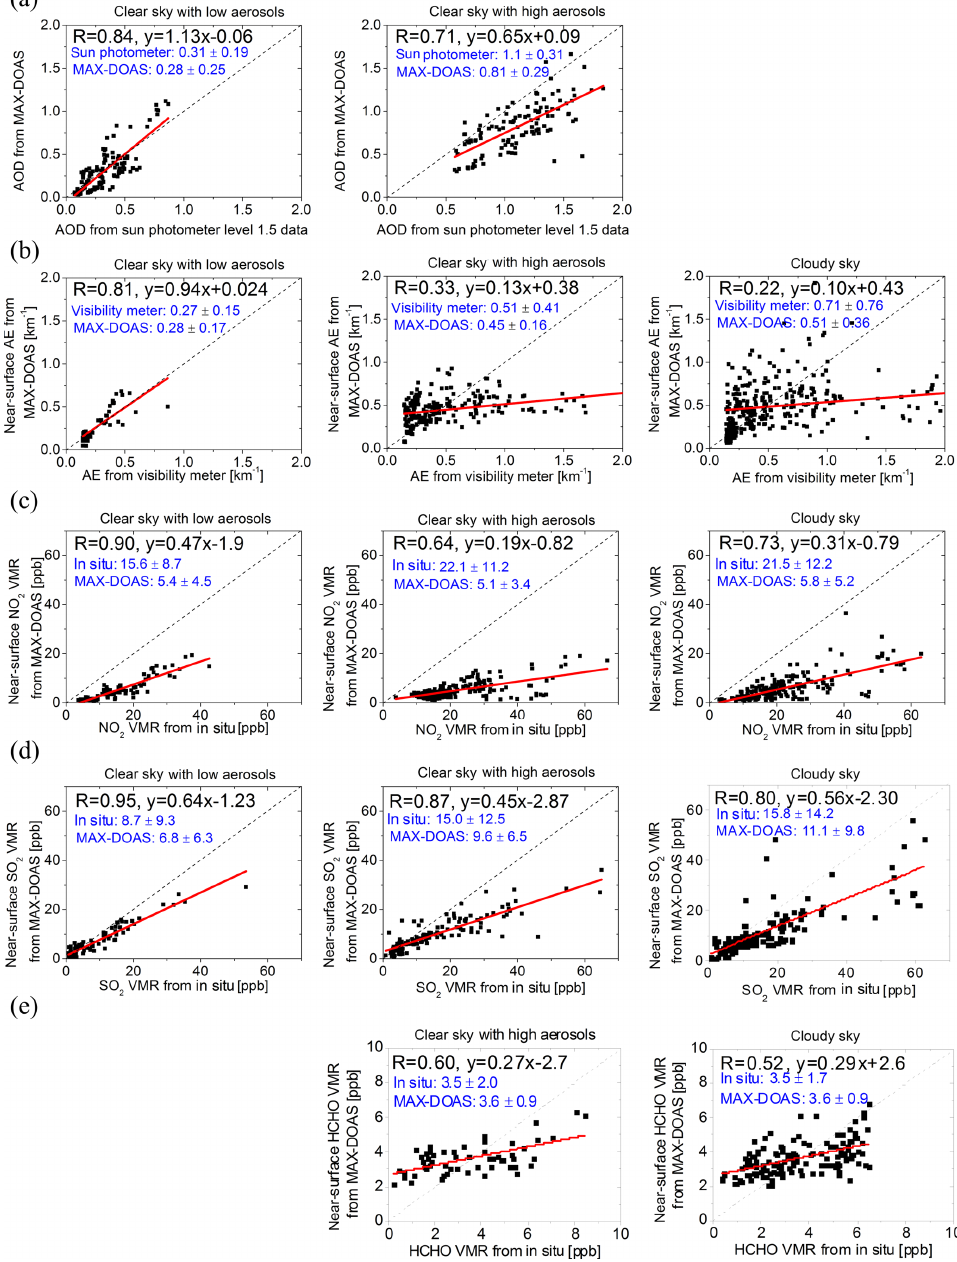
Figure 6. Correlation plots of AODs (a) , near-surface aerosol extinction (b) , and VMRs of NO 2 (c) , SO 2 (d) and HCHO (e) derived from MAX-DOAS measurements versus results from other techniques. Mean values and standard deviations of the compared values are marked by the blue colour and given before and after ± in individual subfigures. AODs are taken from the level 1.5 product (cloud-screened and quality-controlled) derived from sun-photometer measurements. Note that the level 2.0 (quality-assured) AOD product is not (yet) available. Near-surface aerosol extinction is derived from visibility meter measurements. Surface VMRs of NO 2 , SO 2 and HCHO are derived from the in situ instruments (see Sect. 3). The data of the sun photometer, visibility meter, and in situ measurements of NO 2 and SO 2 during the whole campaign period from 8 May to 10 June 2016 are included in the comparisons. The data of in situ measurements of HCHO during the period from 18 to 23 May are included in the comparisons due to the short-term operations of the in situ instrument. All independent data are averaged over the individual time intervals of the MAX-DOAS